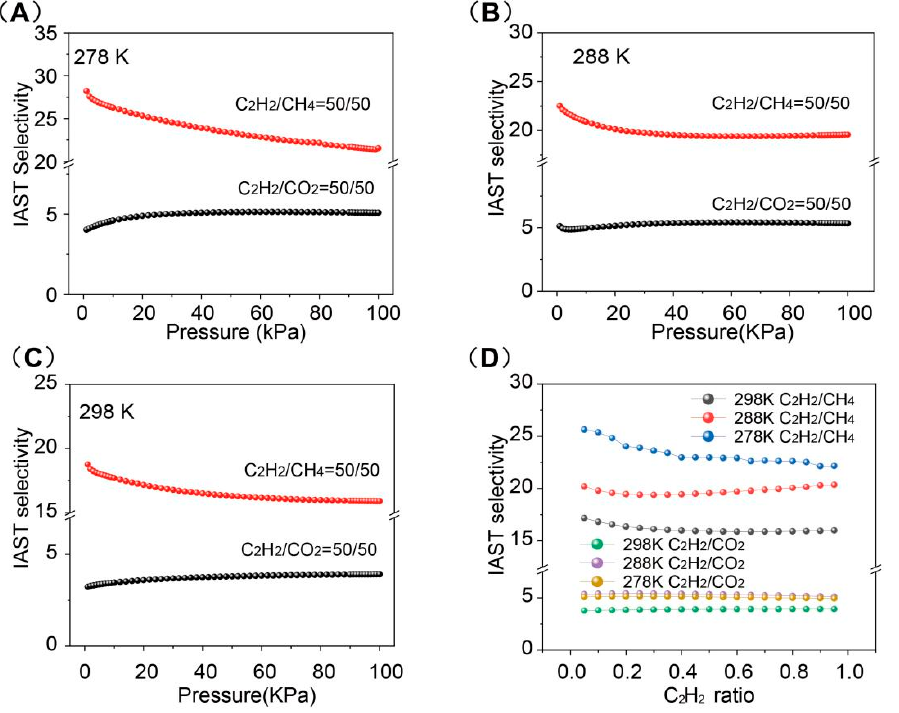
Figure 3. ( A – C ) IAST selectivities for equimolar C 2 H 2 /CO 2 and C 2 H 2 /CH 4 mixture in 1 at 278, 288, and 298 K. ( D ) IAST selectivities for C 2 H 2 /CO 2 and C 2 H 2 /CH 4 mixtures in 1 under 100 kPa with different C 2 H 2 ratio at 278, 288, and 298 K. Table 1. Comparison of the gas adsorption performance of 1 and other MOFs.